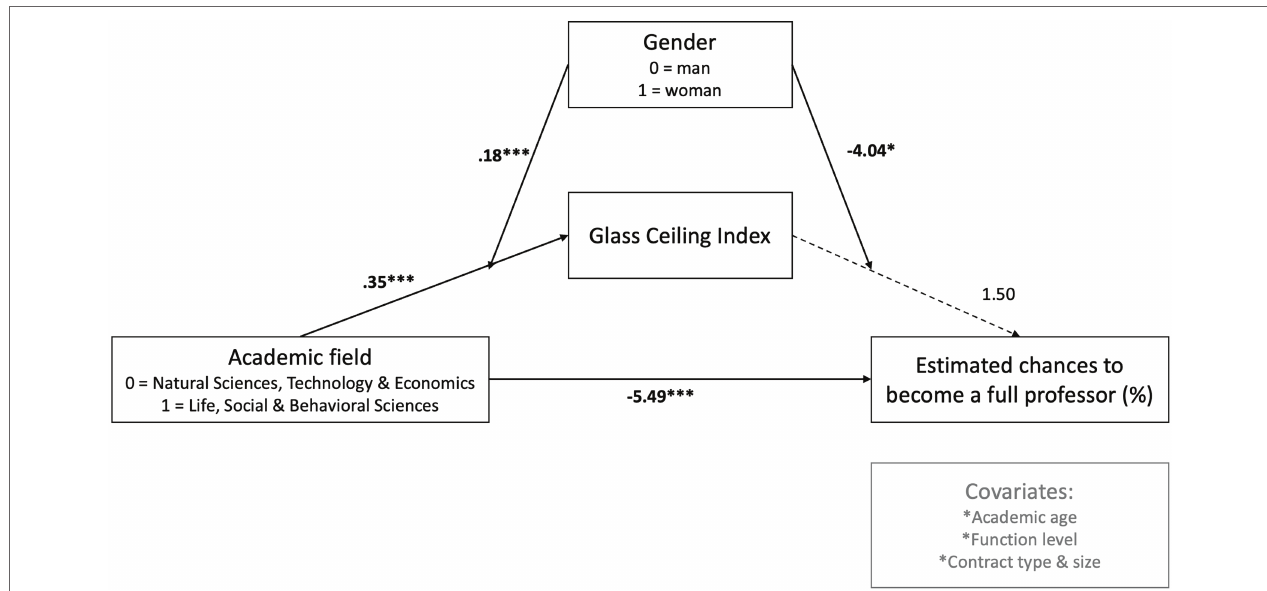
FIGURE 2 | Moderated Mediation model (Model 58 Process) with Academic Field as predictor (X), the Glass Ceiling Index as mediator (M), Estimated Change to become full professor as dependent variable (Y) and Gender as Moderator (Z). Covariates are regressed on both M and Y.